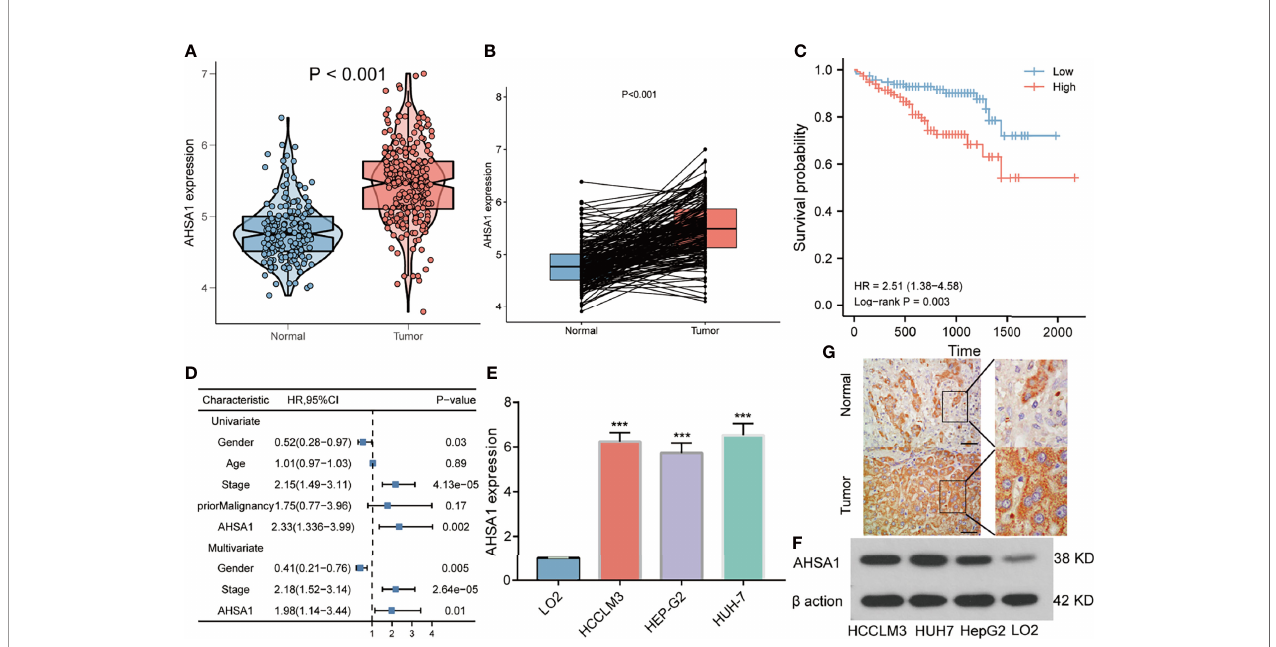
FIGURE 7 | Validation of AHSA1 expression in hepatocellular carcinoma. (A) The mRNA expression of AHSA1 in ICGC cohort. (B) Comparing the AHSA1 expression in paired normal and tumor. (C) The relationship between AHSA1 expression and overall survival in ICGC cohort. (D) Overexpression of AHSA1 was an independent prognostic marker of HCC patients in ICGC cohort. (E) Relative mRNA expression of AHSA1 in HCC cell lines. (F) Expression levels of AHSA1 protein in HCC cell lines. (G) Representative immunohistochemical analysis of AHSA1 in HCC.